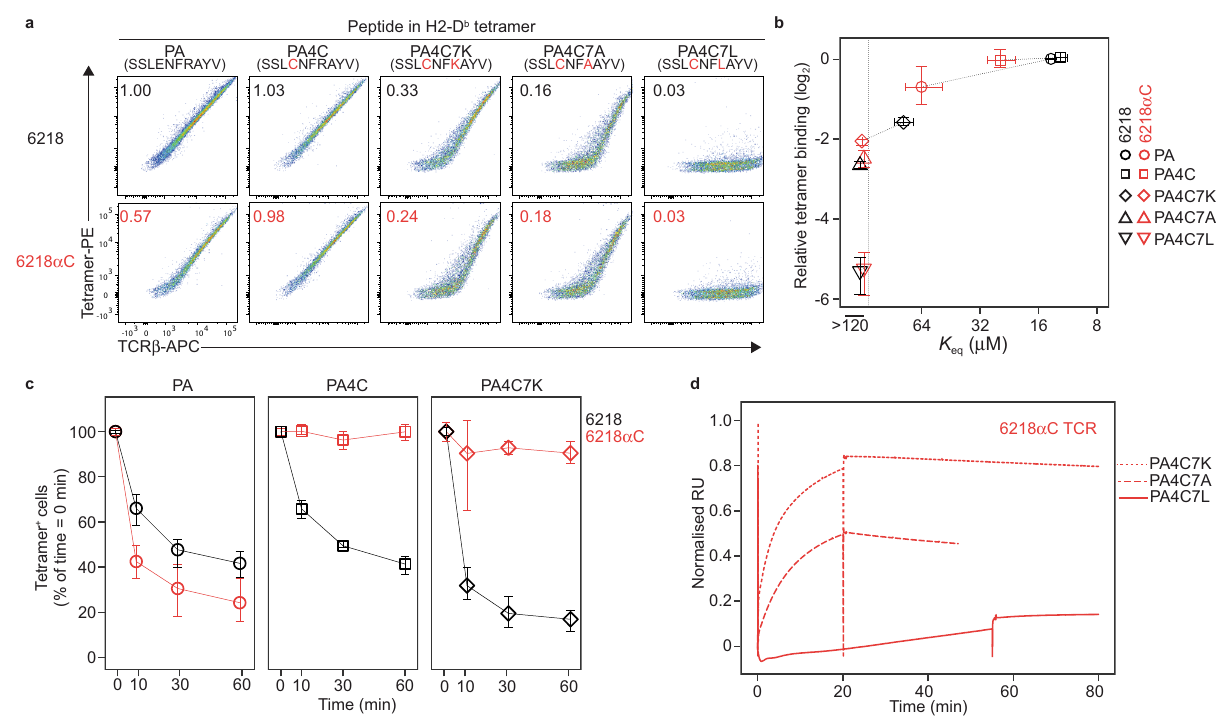
Fig. 7 | S-S bonding across a wide range of TCR af fi nities for pMHC. a Substitutions at P7 of the PA4C peptide decrease TCR binding by pMHC tetra- mers. Plots show FACS phenotypes of TCR transfectants expressing the 6218 or 6218 α C TCR stained with anti-TCR β and tetramers of H2-D b presenting the indi- cated peptide (top). Numbers on plots show the tetramer mean fl uorescence intensity(MFI)dividedbyTCR β MFI,normalizedtothe6218TCR-PA/H2-D b sample. b For the indicated TCR-peptide/H2-D b combinations (right), symbols show the mean tetramer binding, calculated as in a , as a function of the K eq determined by SPR(seeSupplementaryFig.8c),withdottedlinesconnectingmeasurementsfrom thesamepMHC.Errorbarsshowtherangeof3-6samplesfrom2-3experiments( y - axis) or the standard error of the mean of 2 experiments with a total of 4 samples per combination ( x -axis). c S-S bond formation inhibits tetramer dissociation. TCR